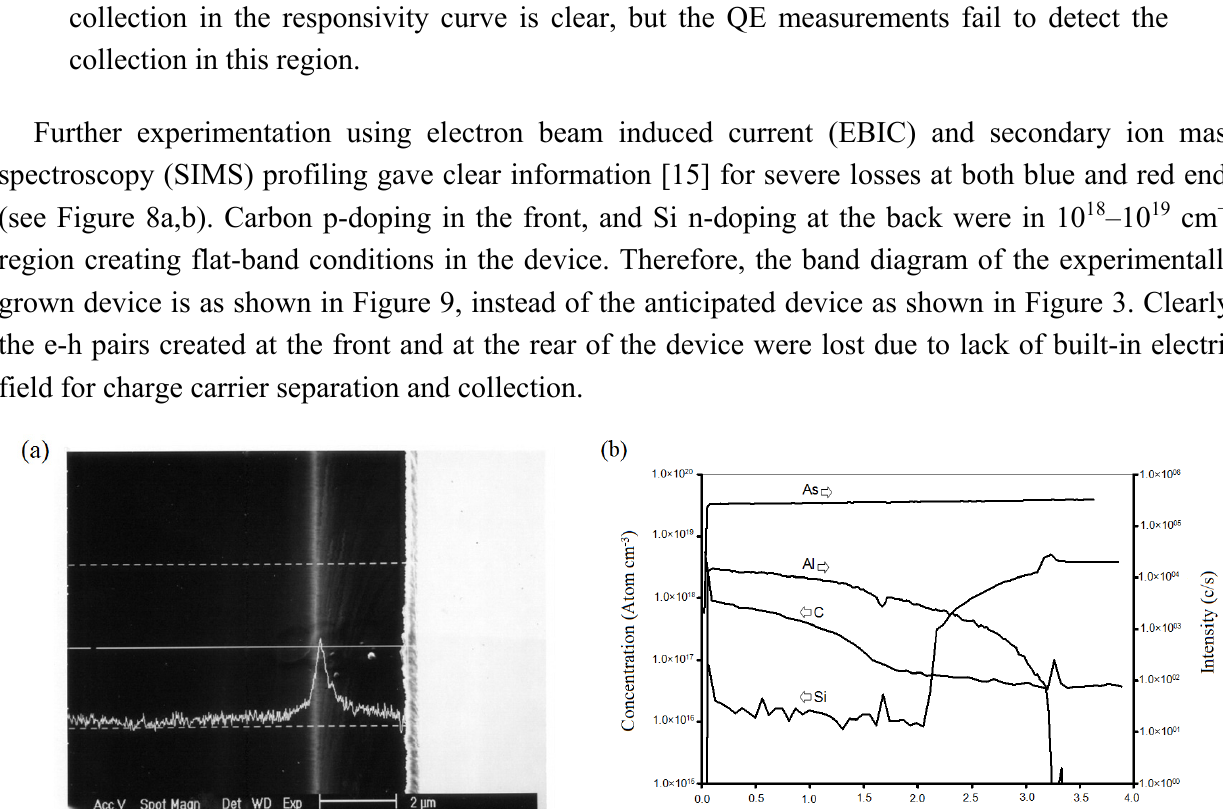
Figure 7. ( a ) A typical QE spectrum and ( b ) a Responsivity curve measured for graded bandgap solar cells. Note the severe loss in both blue and red ends of the spectrum. The IR